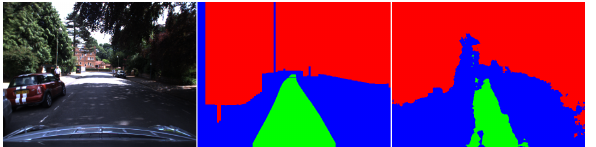
Figure 8: Test image from the RobotCar dataset (left). The same test image but labelled with the weakly-supervised method (mid- dle) and the output of our network fine-tuned on the combined dataset (right).